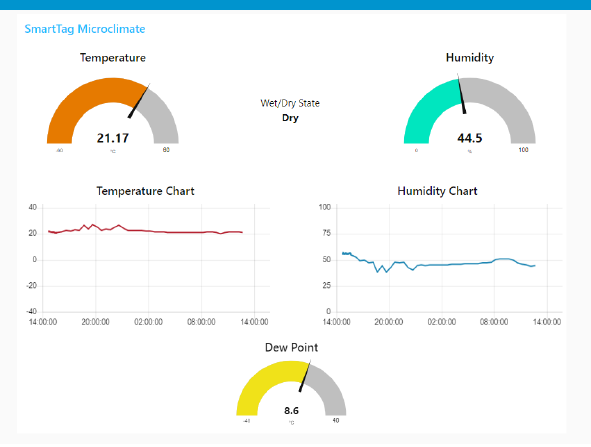
Figure 7. User’s